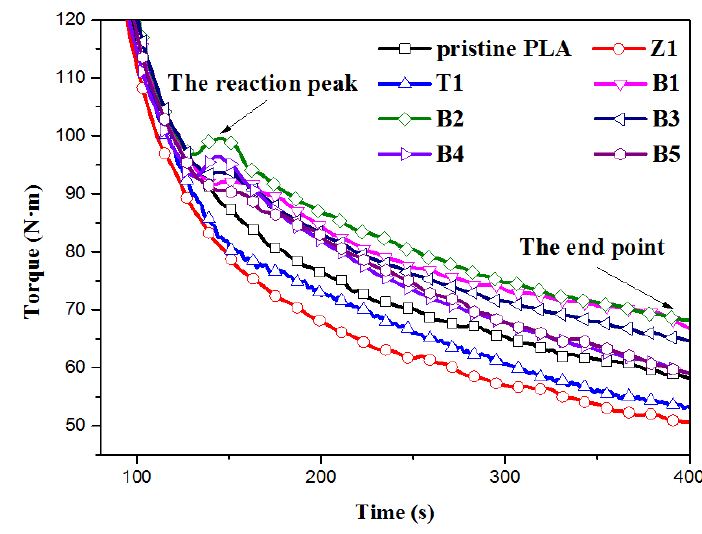
Figure 1. Torque curves of PLA samples at 190 ◦ Figure 1. 1 This is a figure, Schemes follow the same formatting. If there are multiple panels, they should be listed as: ( a ) Description of what is contained in the first panel. ( b ) Description of what is contained in the second panel. Figures should be placed in the main text near to the first time they are cited. A caption on a single line should be centered.